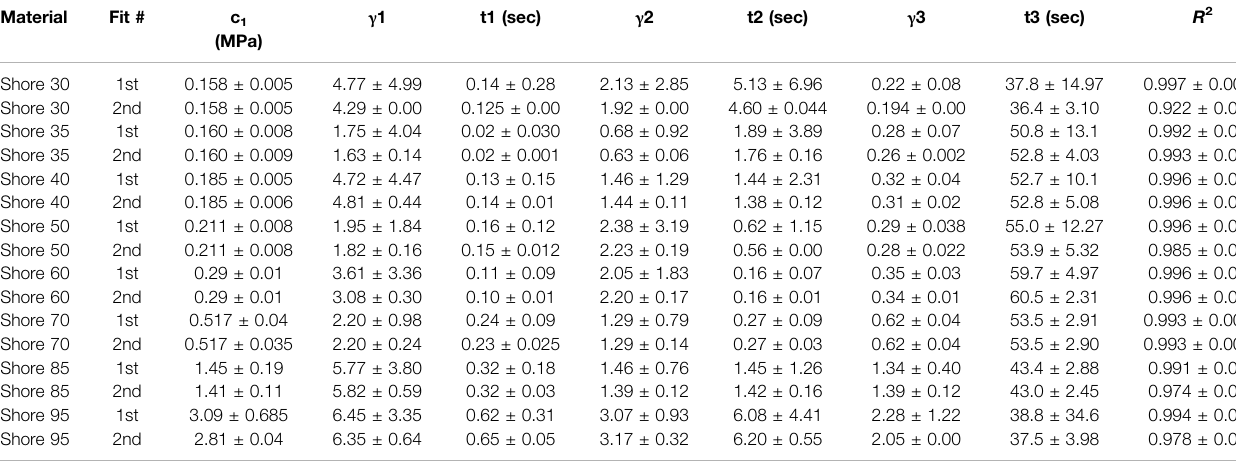
TABLE 2 | Nonlinear viscoelastic incompressible Neo-Hookean fi t to J750 Shore materials. Table of compressible nonlinear viscoelastic compressible Neo-Hookean parametersfortheJ750Shorematerialsalongwiththe R 2 valuesofthe fi